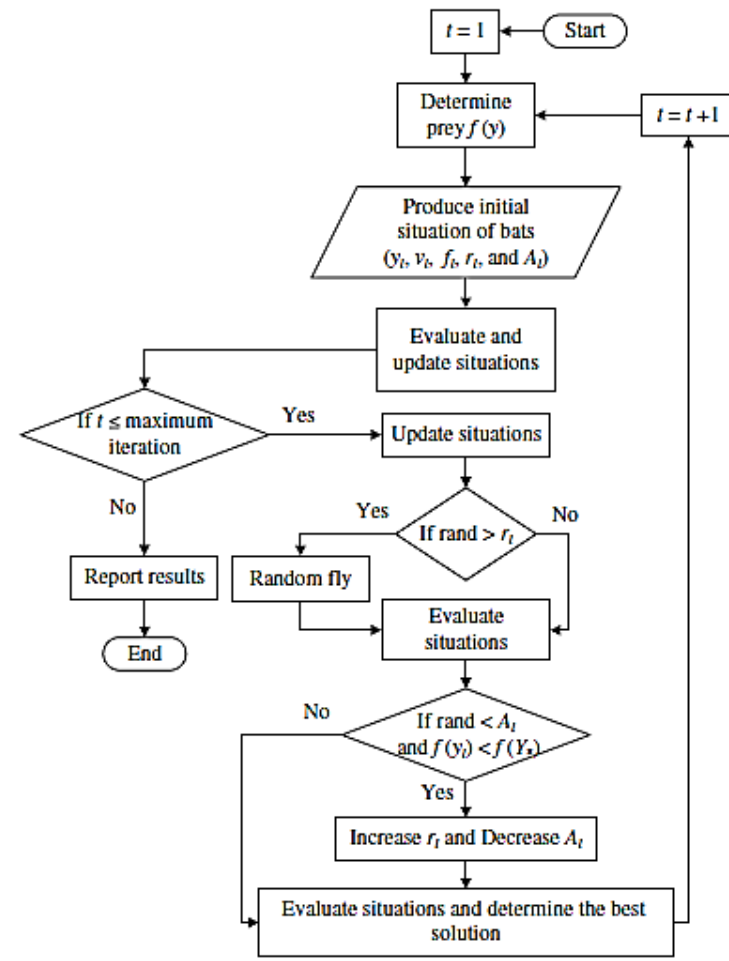
Figure 6. Structure of the bat algorithm (BA).